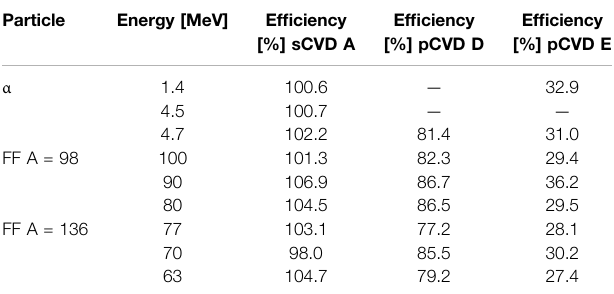
TABLE 2 | Ef fi ciency of different diamond detectors with α and FF (A (cid:1) 98, 136) at different energies. Particle Energy